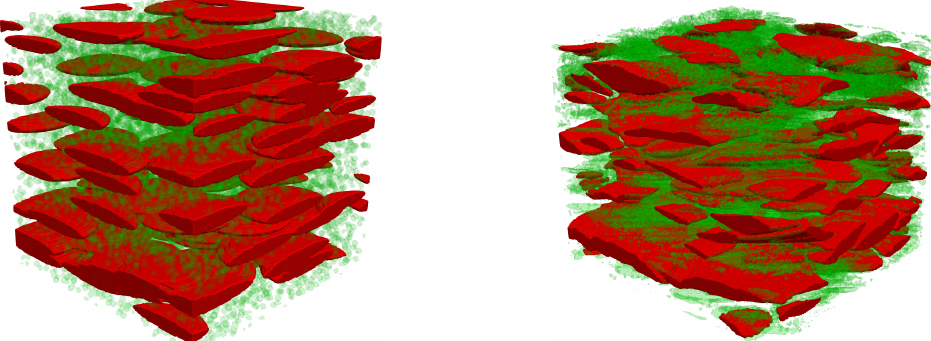
Figure 8. Illustration of the double-scale PSM/PEM reconstruction ( left ) and tomography ( right ) of the EVA-ATH material in the intermediate state of its pyrolysis. The green and red objects represent the meso and macroporosity,